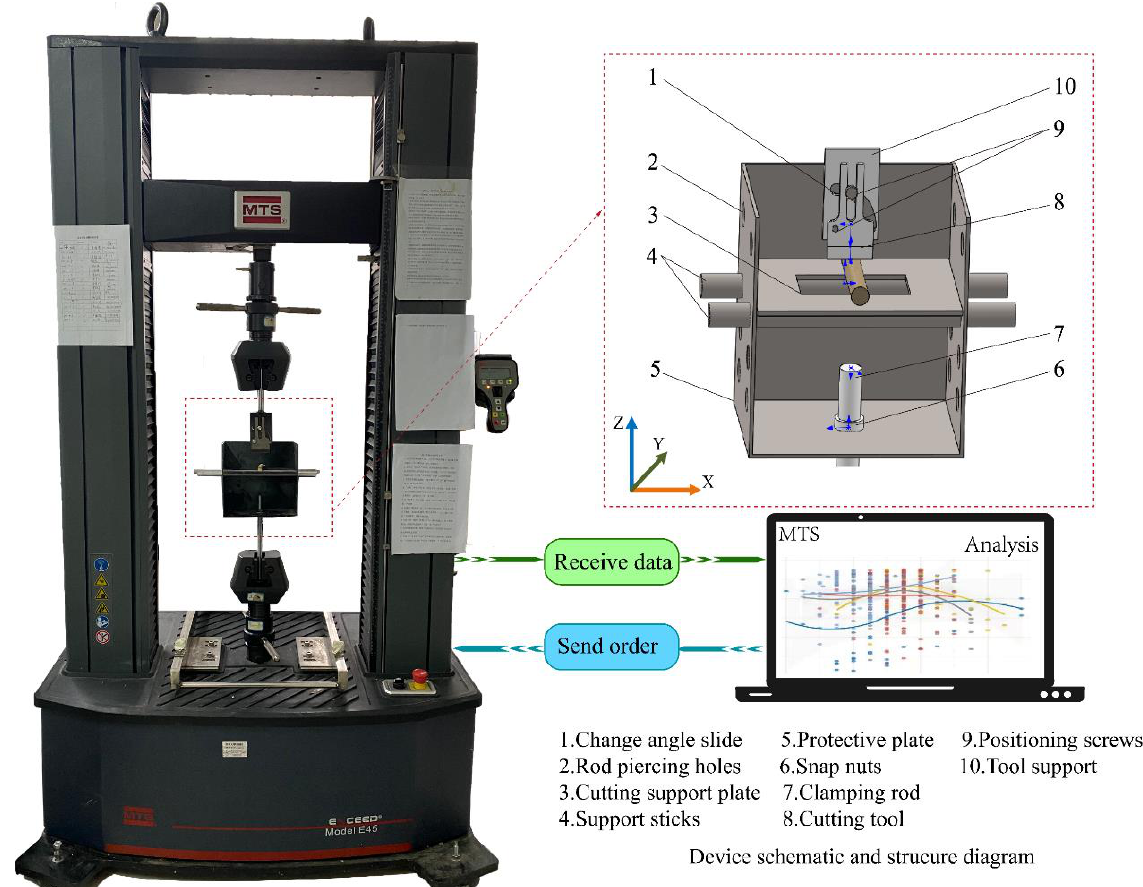
Figure 3. Schematic diagram of the cutting device.